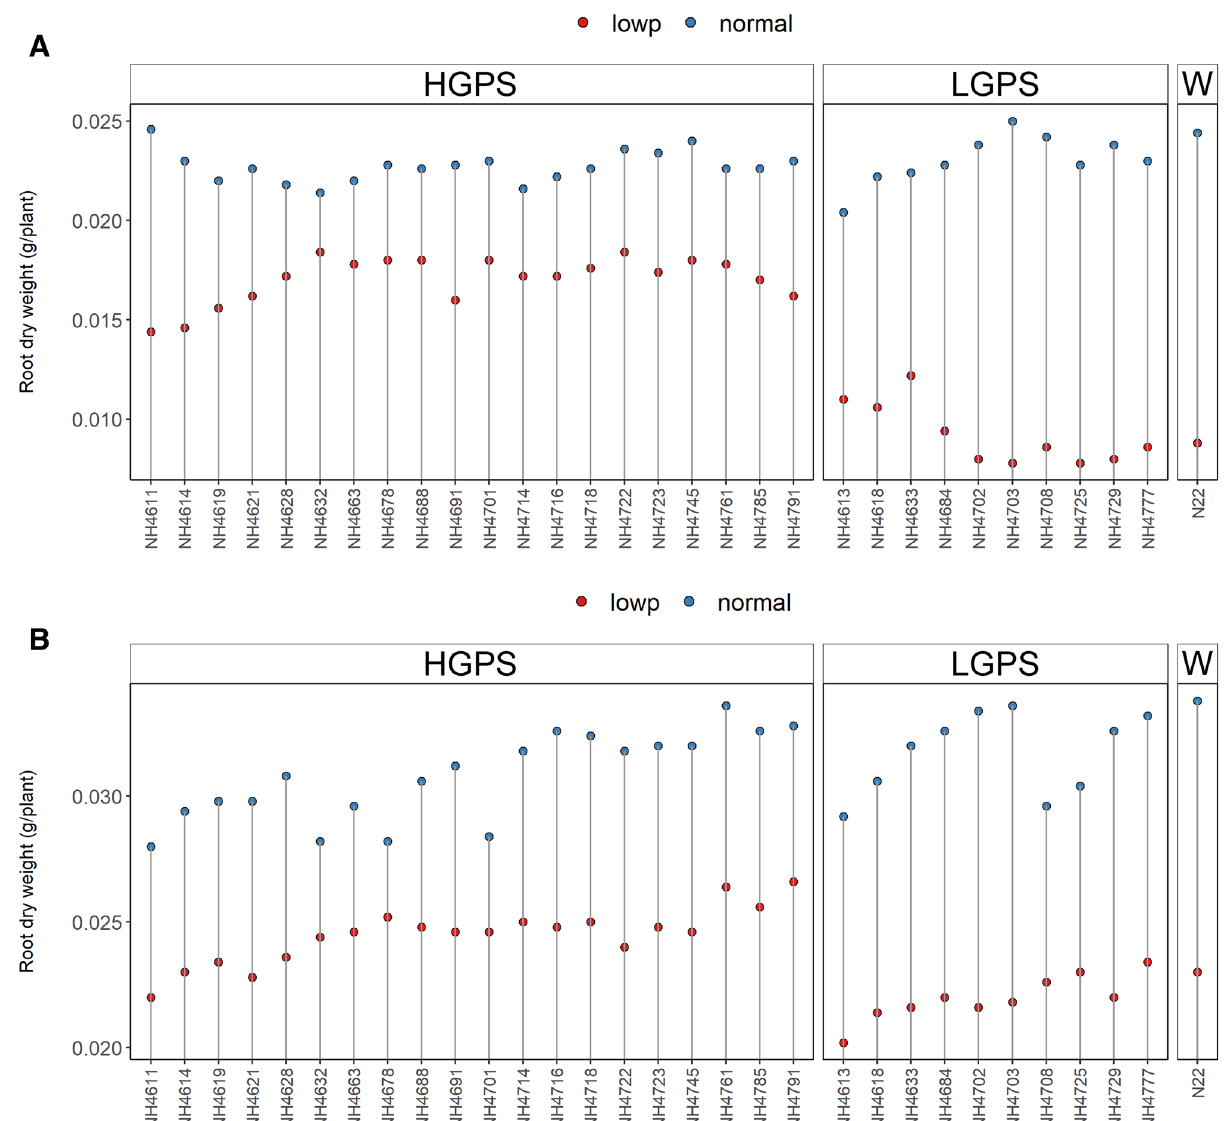
Figure 4. Root dry weight of seedlings obtained from germination of seeds harvested from low P (shown as red dots) and normal P (shown as blue dots) fields. Wild type N22 (W), high grain P mutant seedlings (HGPS), and low grain P mutant seedlings (LGPS) were grown under normal P condition. ( A ) Root dry weight at 12 days of germination. ( B ) Root dry weight at 24 days of germination. The values represent the mean of 20 (Fig. 7). LP- NH4663 showed maximum gain of Chl a when compared with NP- NH4663 , while NH4618 did not show difference under LP and NP conditions at 24 days. Chl b was reduced in all the mutants under LP condition at both the time points, however, the degree of reduction was more severe in LP-LGPS than LP-HGPS (Fig. 8). Mutants NH4785 and NH4791 showed similar Chl b content at 12 days under LP and NP conditions. Similarly, fluorescence parameters such as Fv/Fm and ETR were reduced in all the mutants under LP condition at 24 days. LP-LGPS showed more reduction of Fv/Fm and ETR than LP-HGPS (Fig. 9). Fv/Fm ranged from 0.64 to 0.71 in LP-HGPS and 0.63 to 0.65 in LP-LGPS, while ETR ranged from 20.28 to 22.50 in LP-HGPS and 15.62 to 18.46 in LP-LGPS. Fv/Fm and ETR were comparable in NP-HGPS, NP-LGPS, and NP-N22. P content in root and shoot tissues. The differences in root and shoot P content were significant between LP and NP seedlings and also between HGPS and LGPS at 12 and 24 days (Figs. 10, 11). Compared to NP, the P content was significantly less in LP seedlings in all the mutants but the degree of reduction was more in LP-LGPS than LP-HGPS. The root and shoot P content was 13% and 27% more in LP-HGPS than LP-LGPS at 12d. Similarly, at 24 days, LP-HGPS exhibited 10% and 14% more root and shoot P content than LP-LGPS. At 12 days, LP-HGPS showed 29% and 14% lesser P content than NP-HGPS in root and shoot while LP-LGPS showed 40% and 36% lesser root and shoot P content than NP-LGPS. At 24 days, LP-HGPS showed 29% and